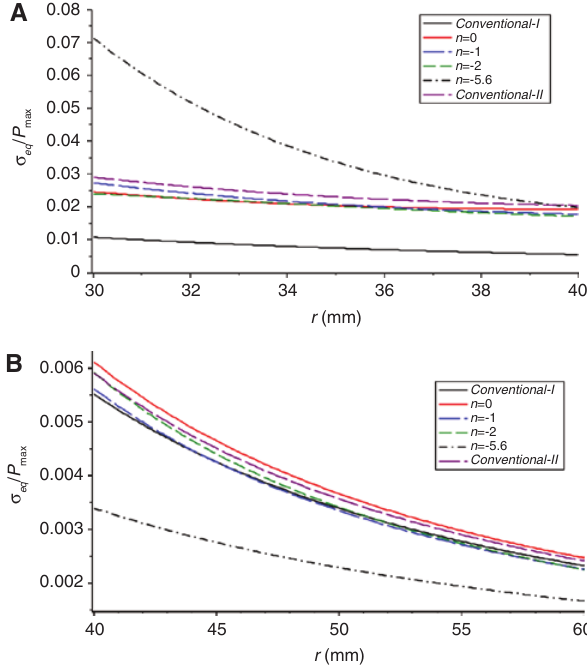
Figure 12: Non-dimensional equivalent stress at θ = 0: (A) in inter-layer and (B) in surrounding plate near